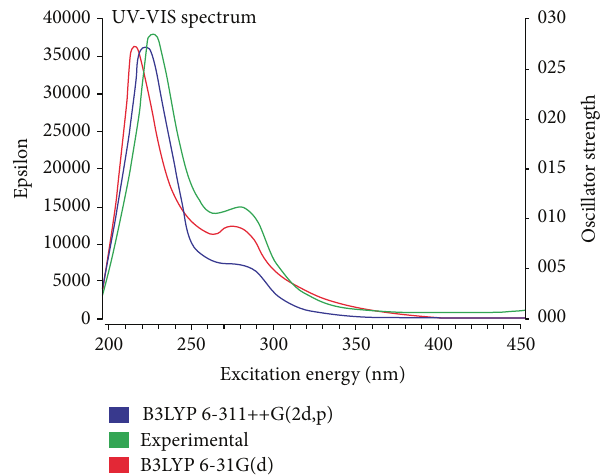
Table 2: Calculated energy values for strictosidine in